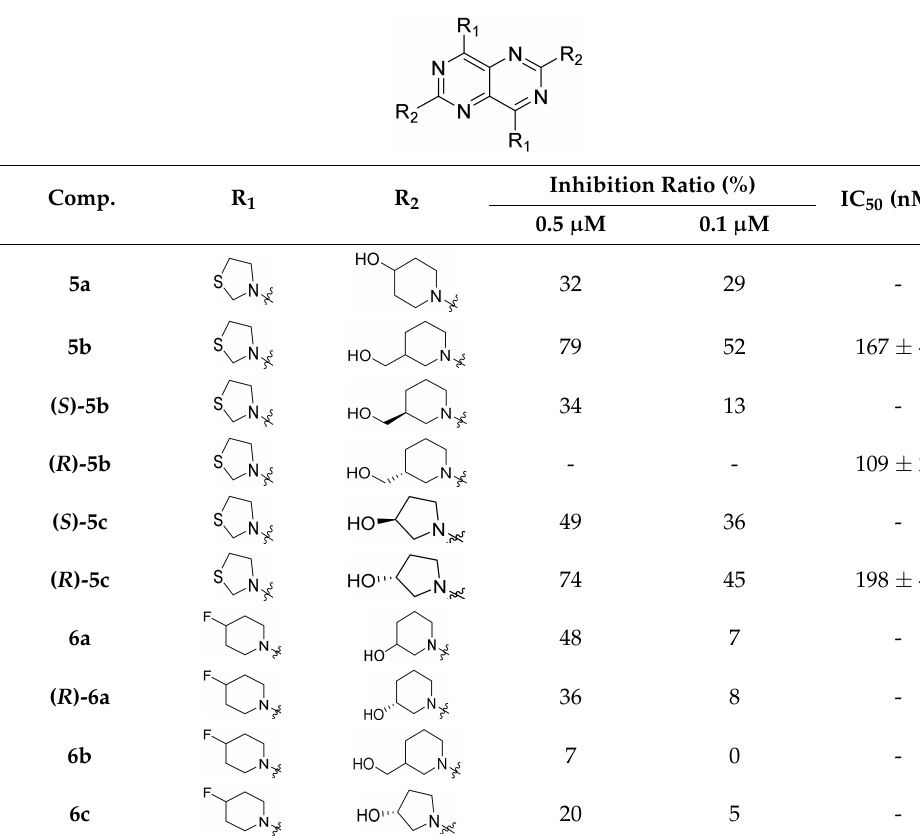
Table 2. The inhibitory activities of target compounds 5a–c , 6a–c against PDE5.